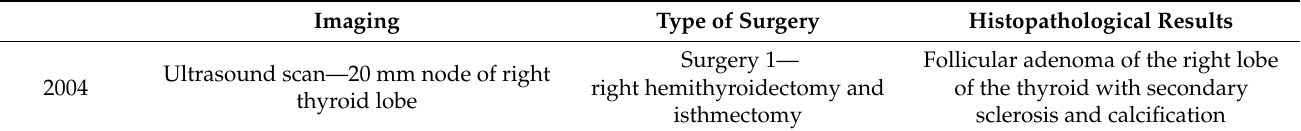
Table 1. Imaging and types of